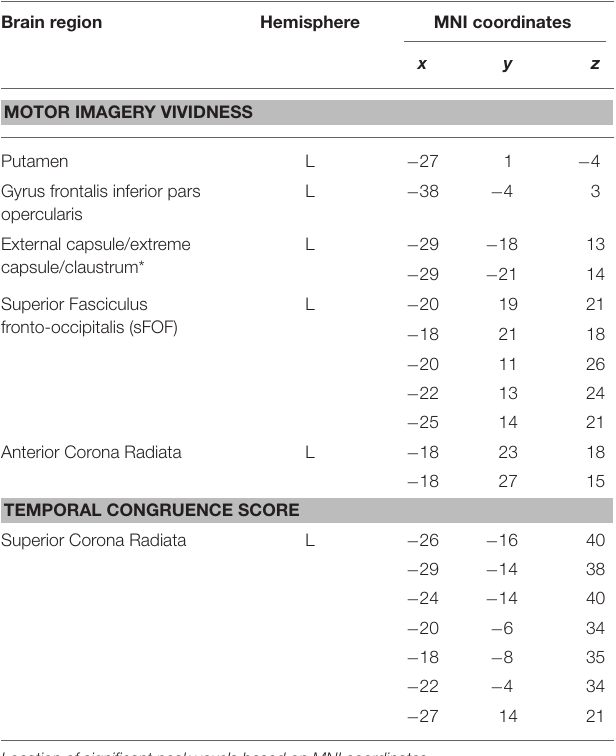
TABLE 3 | Results of the VLSM analyses on motor imagery vividness and temporal congruence performance indices. Brain